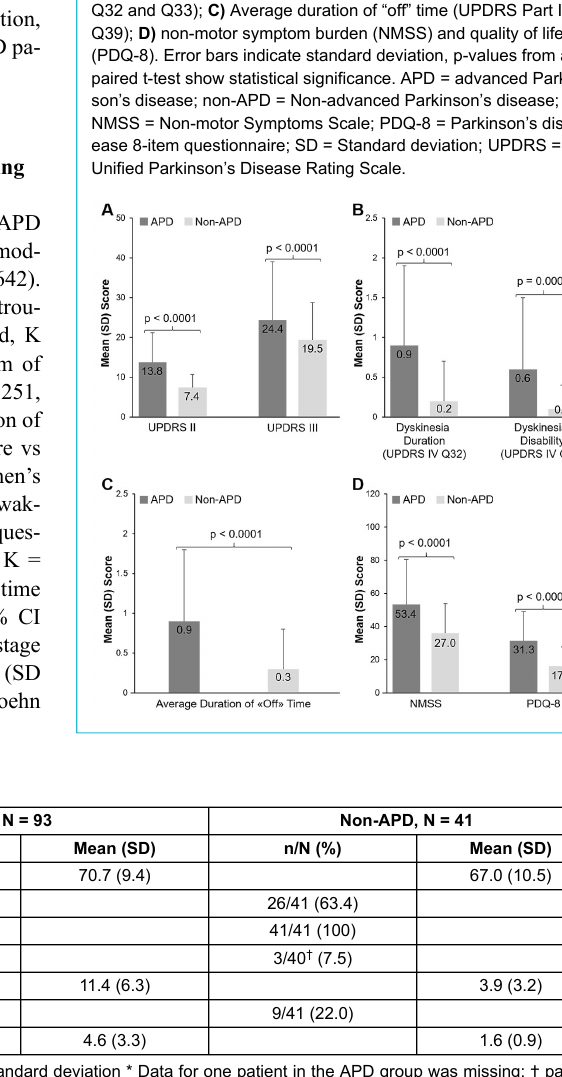
Figure 1: Clinical assessments of APD and Non-APD patients. A) Activities of daily living (UPDRS II), motor symptom severity (UP-